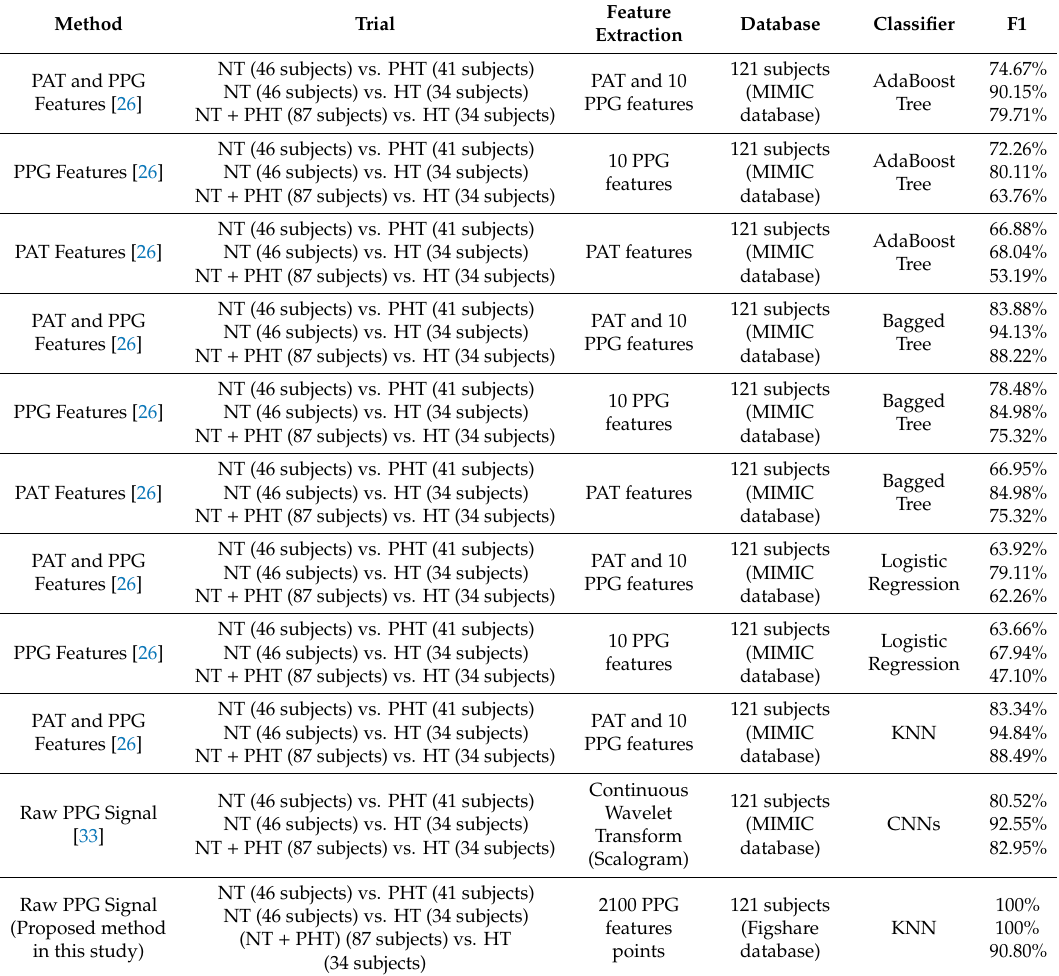
Table 4. Classification performance